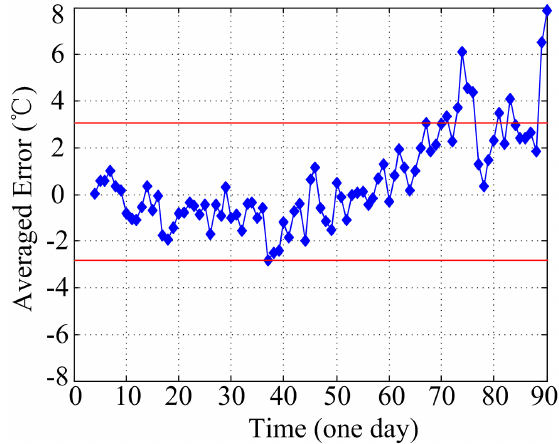
Figure 11. Averaged residual over one day of